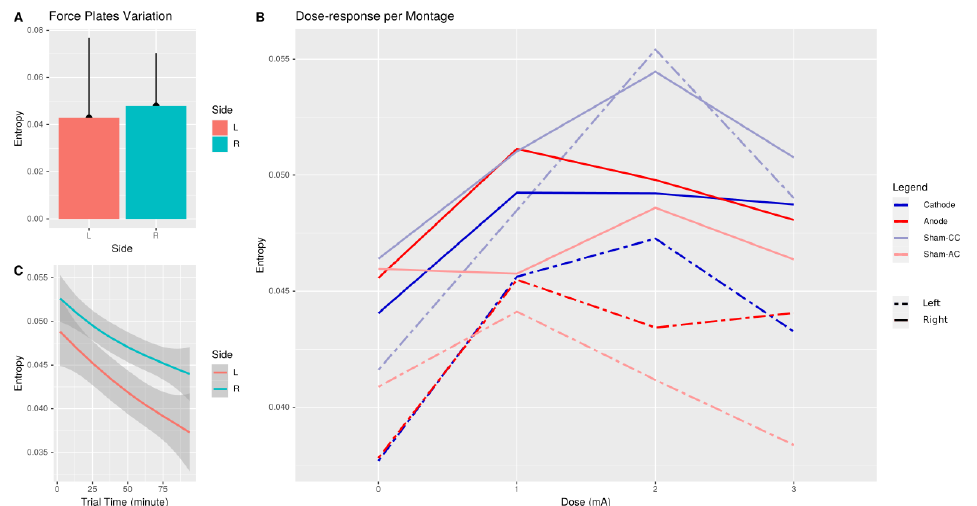
Figure 4. Comparison across the Fz measurements from the platforms and dose-response on each montage. Panel A represents the mean causal entropy from the left side to the right (L) and from the right side to the left (R). The black lines represent one standard error. Panel B shows the transfer entropy of each platform per montage across the dose-response, time-invariant. Panel C displays the nonlinear dynamic and complexity of each platform across time, smoothing the entropy trials evolution through a generalized additive model (GAM) and considering a confidence interval of 95%.